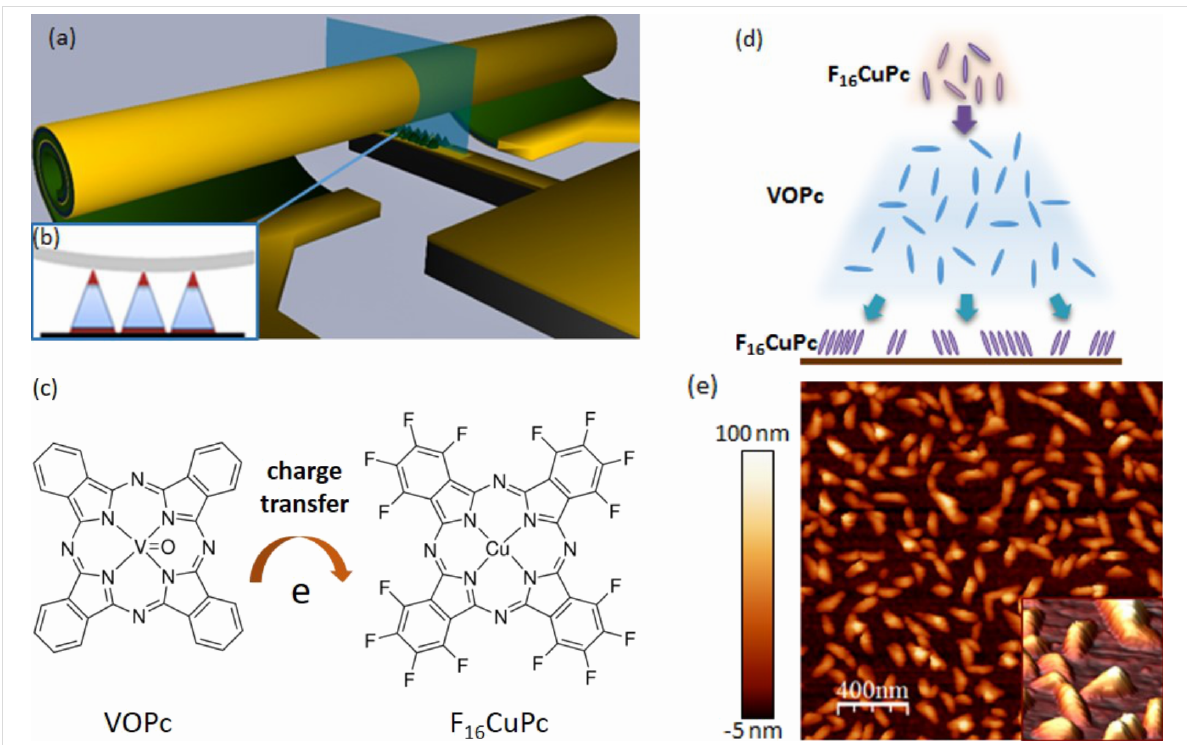
Figure 1: (a) Schematic picture of organic nanocrystal diode with rolled-up contact electrode. (b) Schematic picture of the vertical junction with the nanopyramid sandwiched between the Au mesa electrode and Au tube electrode. (c) Molecular structures of VOPC and F 16 CuPc. (d) Illustration of the F 16 CuPc/VOPc/F 16 CuPc nanopyramid. (e) AFM topography image of the F 16 CuPc/VOPc/F 16 CuPc nanostructures.